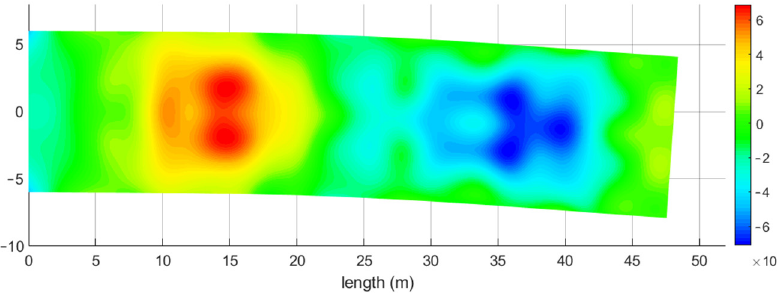
Figure 28. Shear stress τ xy of the cantilever beam (t = 0.58 s), with time-dependent damping.